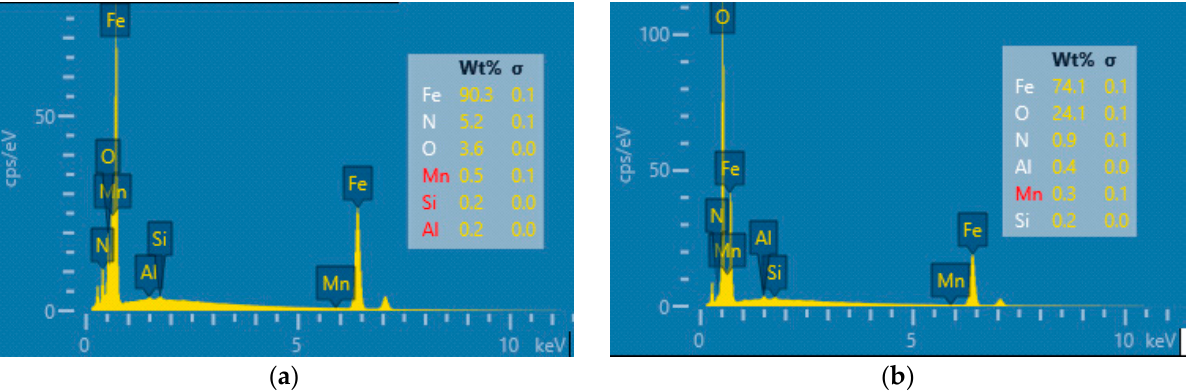
Figure 11. An analysis of the chemical composition of the wear trace for the gas nitrided coating (13 N): ( a ) the area of a uniform material loss (Figure 9b—area 1), ( b ) local cavity (Figure 9b—area 2).